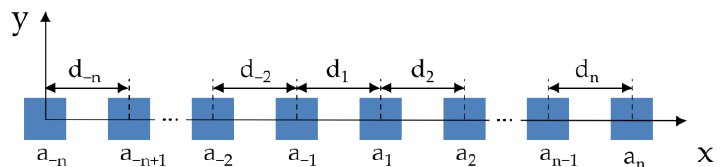
Figure 2. Linear patch array of an even number of elements with the excitation amplitude (a n ) of the nth antenna element and the distance (d n ) between n-1th and nth elements on the x – y plane. Excitation and spacing are set by symmetry (a − n = a n and d − n = d n ).